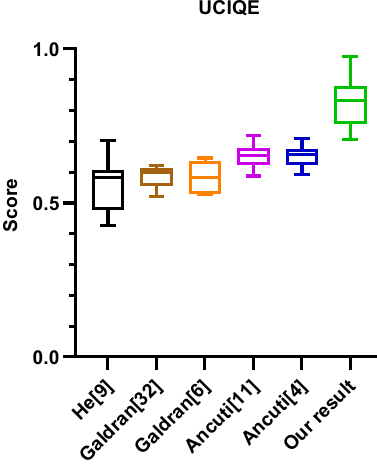
Figure 10. Robustness of the UCIQE metric.